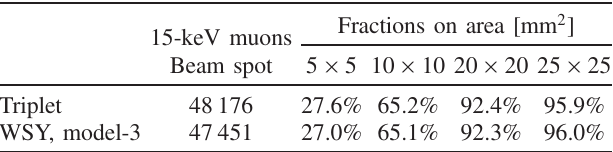
TABLE I. Comparison of beam spot fractions at the LEM sample position for different stray fields using 10 000 simulated muons starting at the